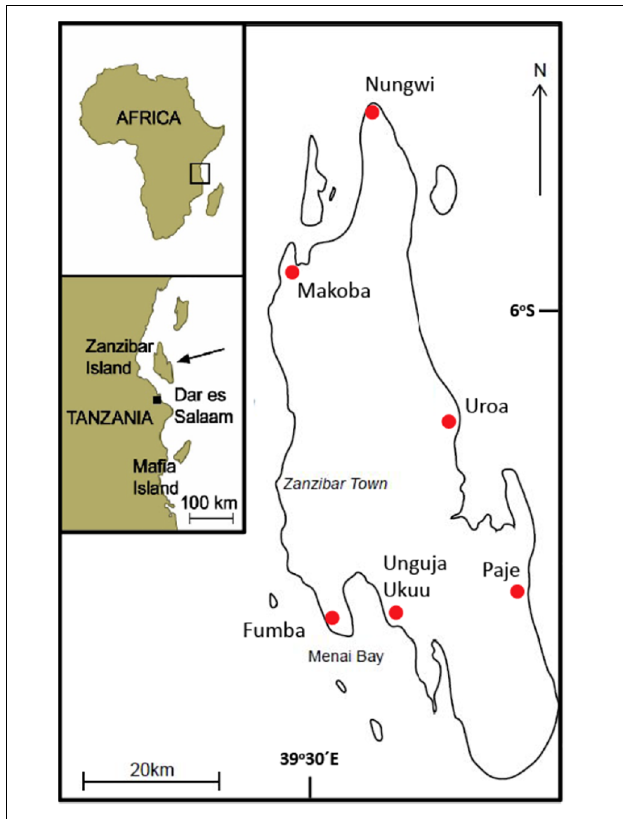
FIGURE 2 | Map of Zanzibar off the east coast of Tanzania. The locations of the six sites, where interviews were conducted, are indicated with red